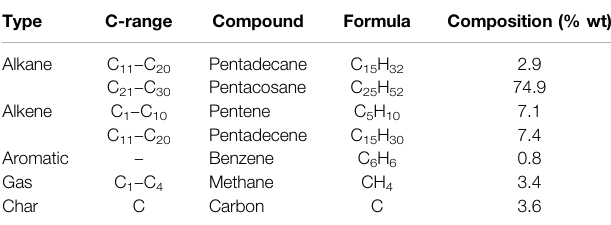
TABLE 2 | Polypropylene pyrolysis products adapted from Mangesh et al. (2020).